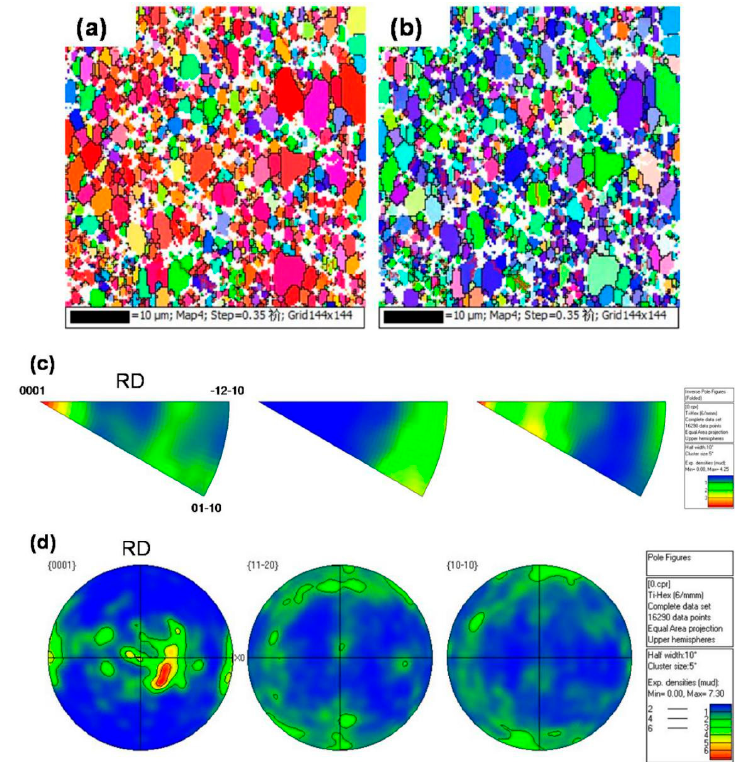
Figure 6. BSE image of microstructures obtained by different solid solution treatment: ( a ) 940 °C ×1 h, AC; and ( b ) 980 °C × 1 h, AC.